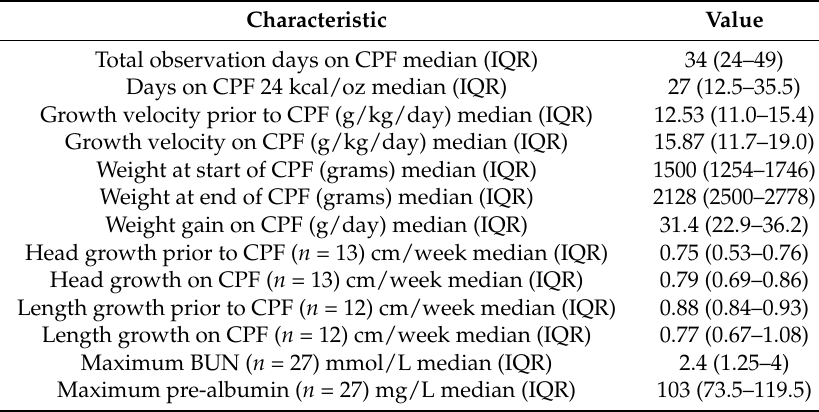
Table 4. Growth and laboratory data on CPF ( n = 23, unless specified